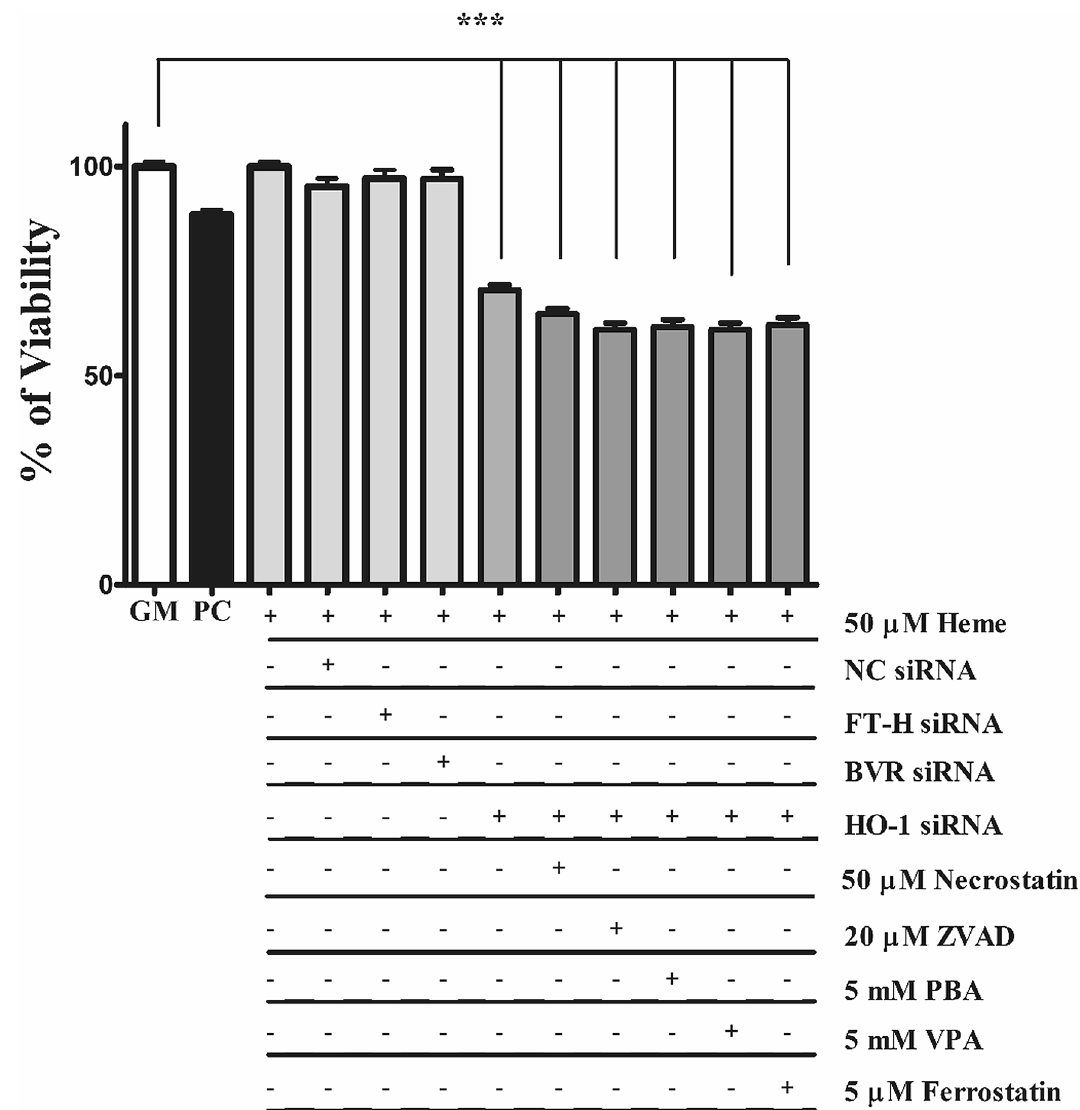
Figure 11. Knocking down HO-1 induces cell death in EC cultures that cannot be counterbalanced by currently known cell death inhibitors. Cells were plated on 96-well black plates and silenced as described above. ECs were exposed to heme (50 μM) in a culture medium containing 5% FBS. Parallel with that, ECs were exposed to well-known inhibitors of necroptosis (50 μM necrostatin), apoptosis (20 μM ZVAD), and ferroptosis (5 μM ferrostatin), or, ER stress inhibitors (5 mM phenylbutyric acid or 5 mM valproic acid) for 30 min in complete growth medium with 10% FCS, then exposed to heme (50 μM) for 24 h in CM199 with 5% FCS. Cells were then washed with HBSS+ and calcein AM was added to the cell in a final concentration of 1 µM and further incubated for 30 min in HBSS+. Fluorescence was measured at Ex/Em = 485/530 nm. Data are shown as mean ± SEM of three independent experiments. Statistical analysis was performed by one-way ANOVA test followed by Bonferroni correction. A value of p < 0.05 was considered significant. *** p <